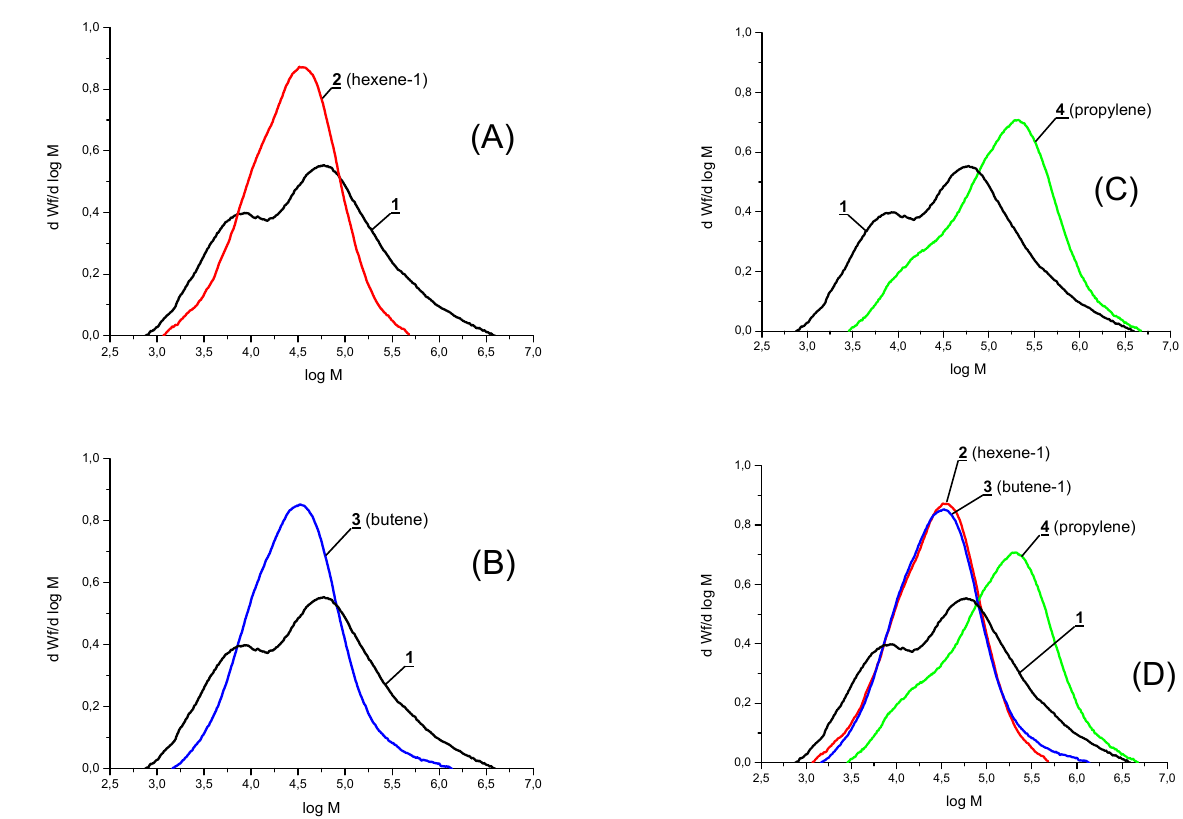
Figure 6. MWD curves for polymer samples obtained during ethylene polymerization in the presence of hexene-1 ( A , curve 2), butene-1 ( B , curve 3), propylene ( C , curve 4) and in the absence of α -olefins (curve 1 in A – D ); ( D )—MWD curves for all polymers obtained in exps. 1–4 (Table 3). The data of Table 3 (exps. 2 and 3) and Figure 6 show that the presence of hexene-1 and butene-1 in ethylene polymerization leads to drastic changes in the molecular mass characteristics of the produced polymers in comparison with those obtained in homopoly- merization (exp. 1). The PE samples of exps. 2 and 3 show narrower monomodal MWD (the value M w /M n = 3.0–3.4). It is seen that the decrease in the M w value in exps. 2 and